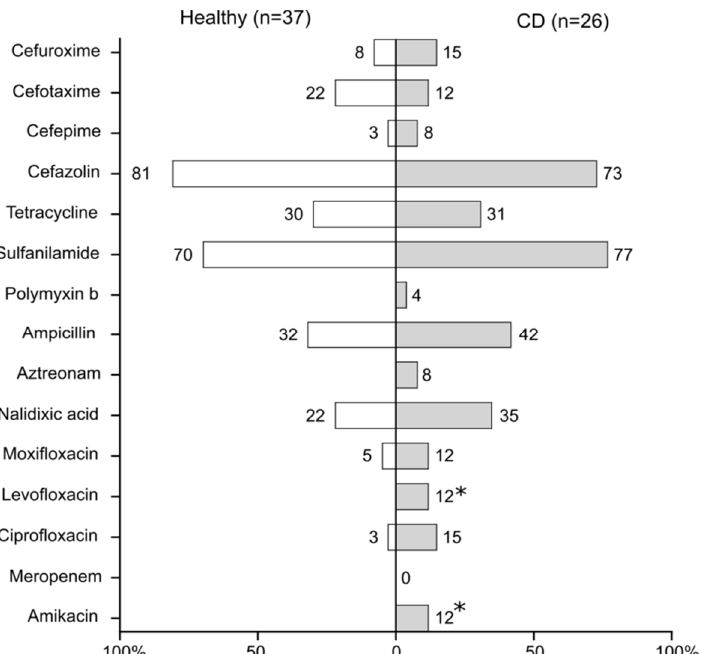
Figure 4. Susceptibility of E. coli strains from patients with Crohn’s disease (CD) and healthy individuals to the antibiotics. Numbers indicate the percent of non-susceptible strains (* p < 0.1, Fisher’s exact test).